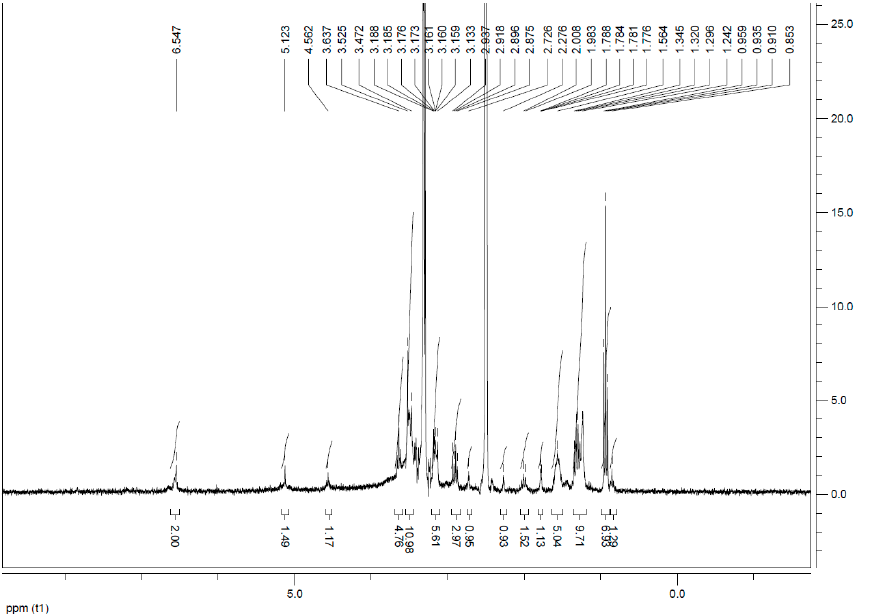
Figure A12. 1 H NMR spectrum of AuNPs 2a in d 6 -DMSO with the characteristic signals of the furan-protected maleimide at 6.55, 5.12, and 4.56 ppm.